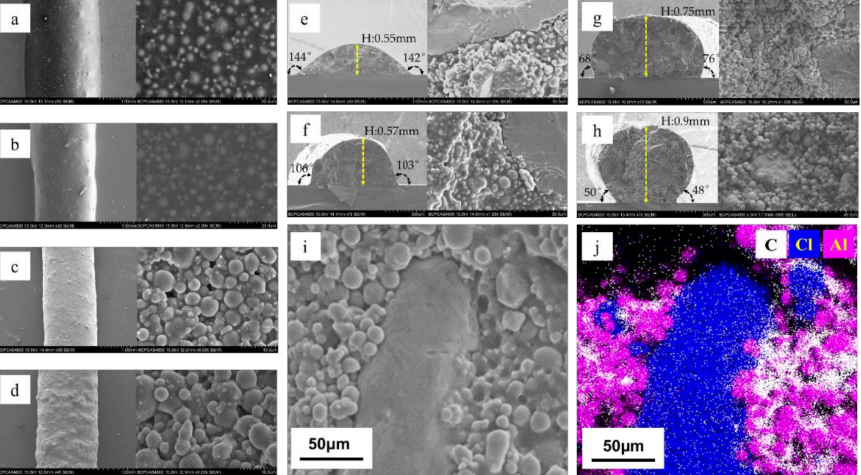
Figure 5. SEM images and element analysis image of four samples with different solid contents: ( a ) SEM images of 80% sample surface; ( b ) SEM images of 85% sample surface; ( c ) SEM images of 90% sample surface; ( d ) SEM images of 91% sample surface; ( e ) SEM image of 80% sample cross section; ( f ) SEM image of 85% sample cross section; ( g ) SEM image of 90% sample cross section; ( h ) SEM image of 91% sample cross section; ( i ) SEM image of 91% sample surface; ( j ) element analysis image of 91% sample surface (white is C, blue is Cl, and pink is